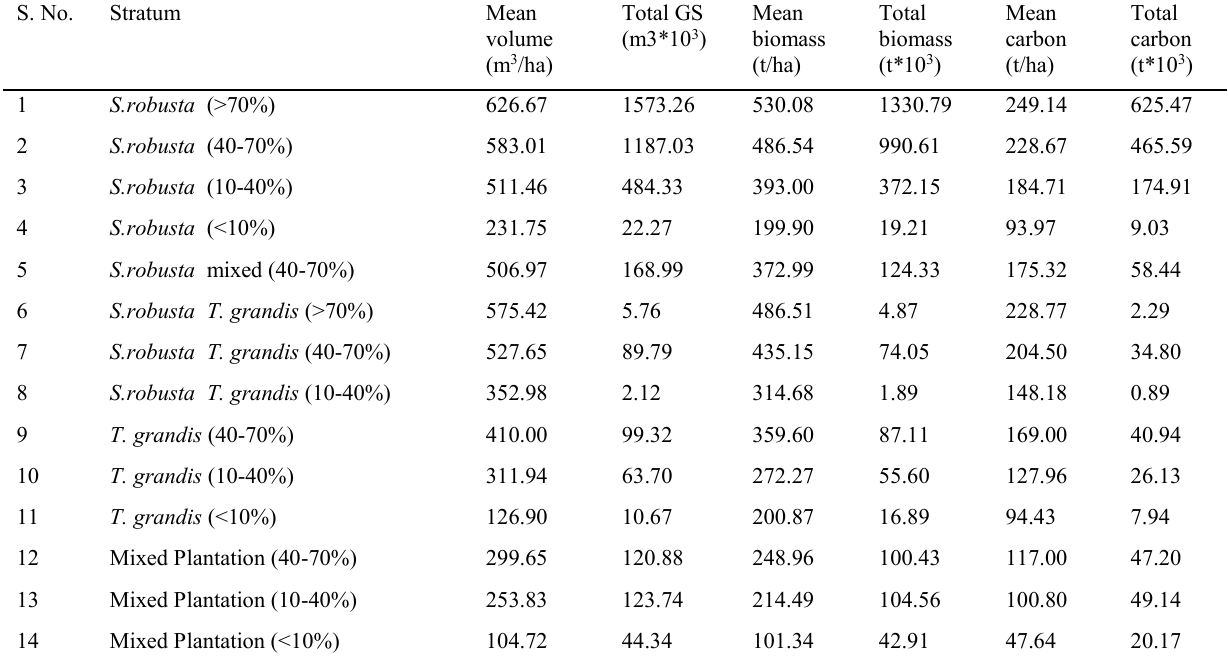
Table 2. Growing stock, biomass and carbon in different forest stratum.